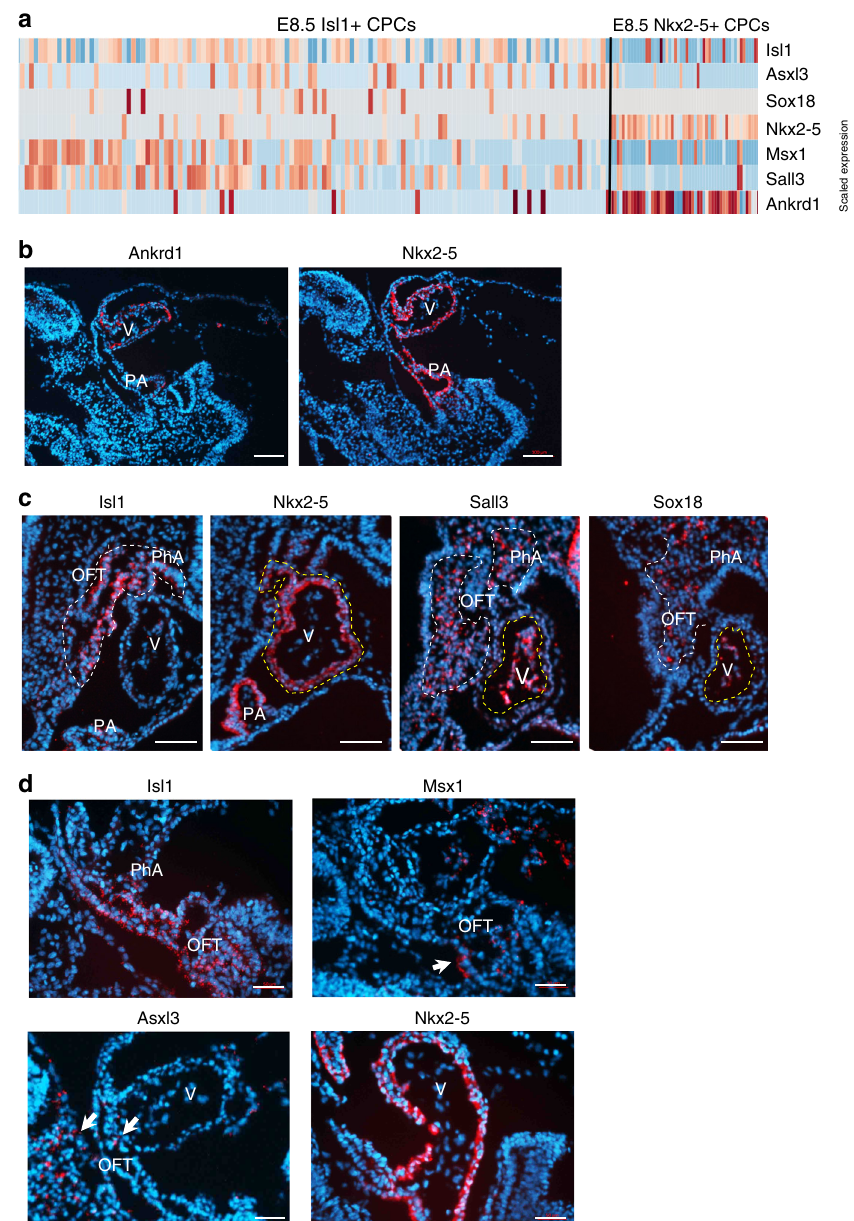
Fig. 4 Spatial expression pattern of genes identi fi ed by scRNA-seq of CPCs. a Heatmap showing expression of selected genes in Isl1 + and Nkx2-5 + CPCs at E8.5. b – d In situ hybridization of sections from E8.5 embryos to reveal spatial expression pro fi les of genes identi fi ed by scRNA-seq. Scale bar: 100 μ m for ( b ), 50 μ m for ( c , d ). V: ventricle. PA: primitive atria. PhA: pharyngeal arches. OFT: out fl ow tract. Arrows indicate positive